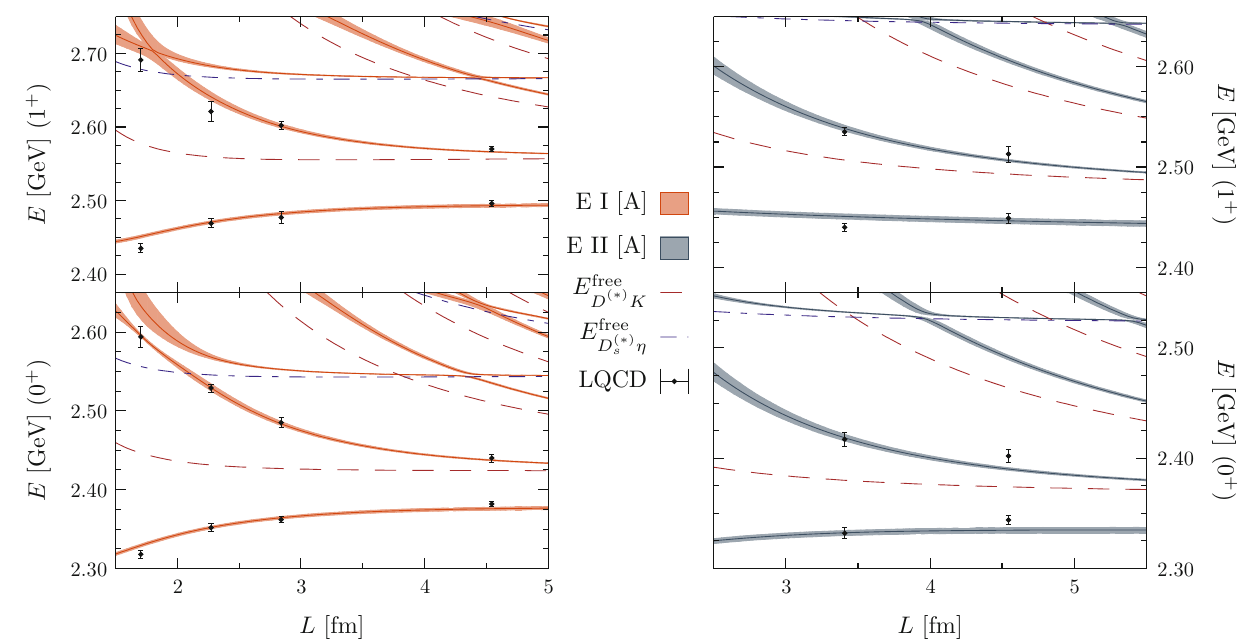
Fig. 1 Black points: LQCD J π = 0 + (bottom panels) and J π = 1 + (top panels) energy-levels, taken from Ref. [38], for different volumes and pion masses. LQCD data for Ensembles I and II are depicted in the left and right panels, respectively. Solid lines: Energy-levels obtained from 0 + and 1 + combined fits to Ensembles I and II using the Set A of CQM bare masses, as a function of the box-size, L (some volume inter- polatedmesonmassesareusedtocomputethecontinuousenergy-levels for values of L different than those employed in Ref. [38]). Details of the fits and some derived quantities are collected in Table 3. Statisti- cal 68%-confident level (CL) bands are also shown. They are calculated